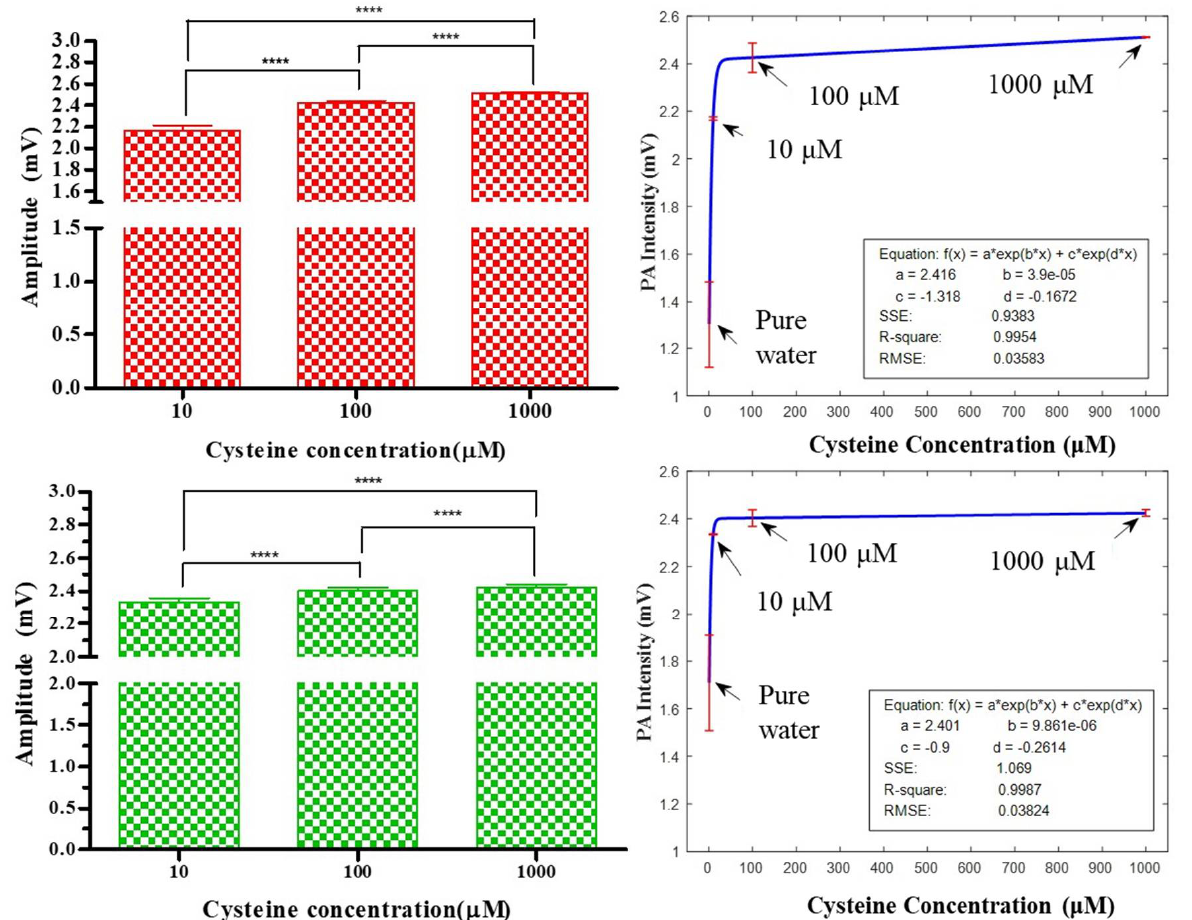
Figure 6. The red and green color bars represent the PA amplitudes of Au@Cys NRs and Au@Cys NPs irradiated by 658 nm and 520 nm lasers, respectively. The fitted curves summarize the relationships between the amplitude intensities and four concentrations (pure water, 10, 100, and 1000 μM). The means and standard deviations are plotted according to a series of PA amplitudes (N = 196) for the best fit. **** Significantly p <